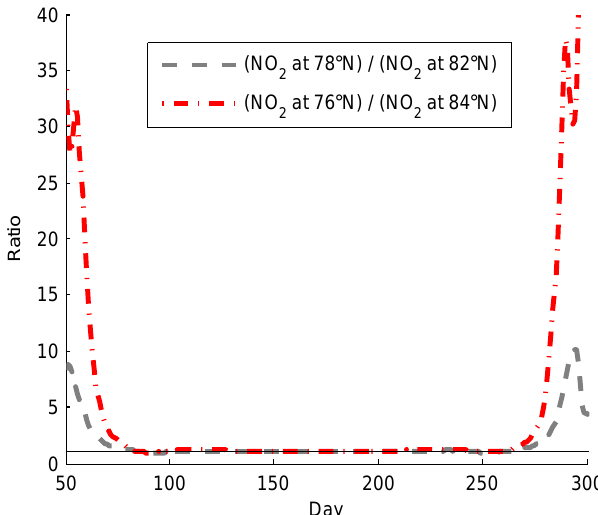
Fig. 5. Ratios of 17–40km NO 2 partial columns at various latitudes during the evening twilight, calculated with photochemical model initialized with climatological ozone and temperatures. During the spring and fall, when the sun rises and sets, the evening twilight is defined as SZA=90 ◦ . During polar night, the evening twilight is de- fined as the minimum available SZA. During summer, when the sun is above the horizon 24-h per day, the evening twilight is defined as the maximum available SZA. 76 ◦ N to 84 ◦ N is the maximum range over which coincident measurements were selected (see Fig. 2). The thin black line indicates a ratio of